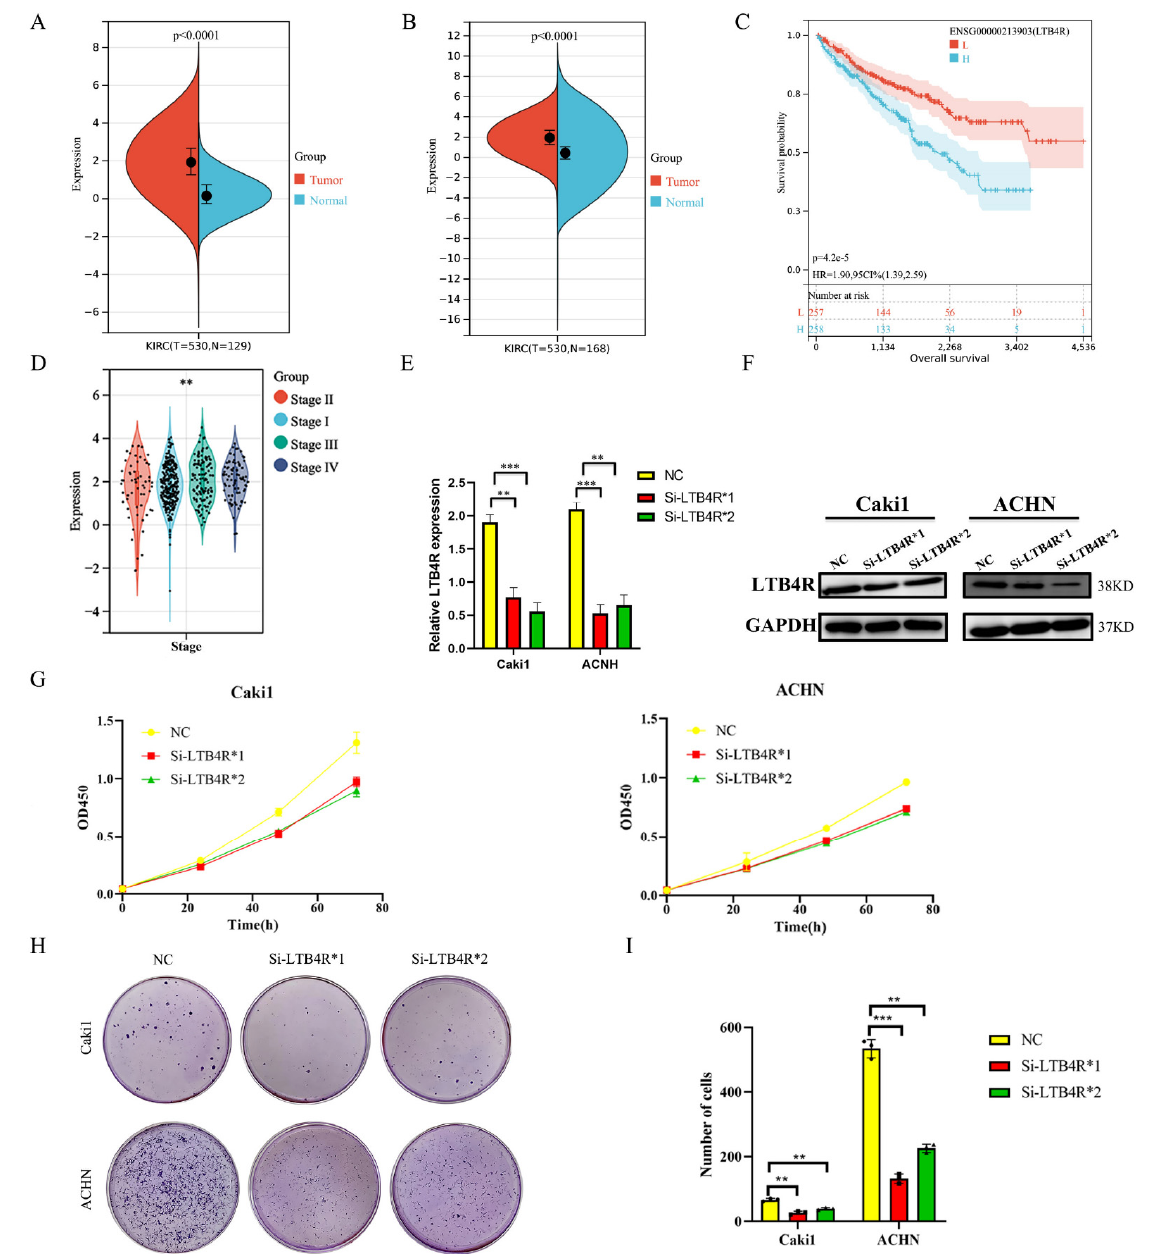
Figure 1. The expression of LTB4R and its relationship with survival and clinical traits in ccRCC. LTB4R knockdown inhibited the proliferation and colony formation of ccRCC cells. ( A ) Expression difference of LTB4R between ccRCC samples ( n = 530) and normal samples ( n = 129) by using TCGA and GTEx databases. Wilcoxon rank-sum test, p < 0.0001. ( B ) Expression difference of LTB4R between ccRCC samples ( n = 530) and normal samples ( n = 168) by using TCGA database. Wilcoxon rank-sum test, p < 0.0001. ( C ) Risk model survival curve analysis. Log-rank test, p = 4.2 × 10 − 5 . ( D ) High expression of LTB4R was related to higher tumor stage. Wilcoxon rank-sum test, ** p < 0.001. ( E ) RT-qPCR detected the knockdown efficiency of LTB4R. ( F ) Western Blot Analysis to verify the knockdown efficiency of LTB4R. ( G ) Knockdown of LTB4R inhibited the proliferation of Caki1 and ACHN cells. ( H , I ) After knockdown of LTB4R, the cloning formation ability of Caki1 and ACHN cells were decreased. A 2-tailed t test was used in E and I (** p < 0.01, *** p <